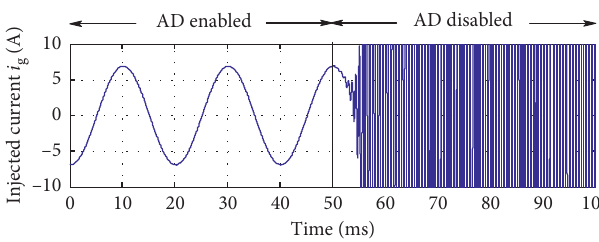
Figure 10: Simulation result at full load conditions.